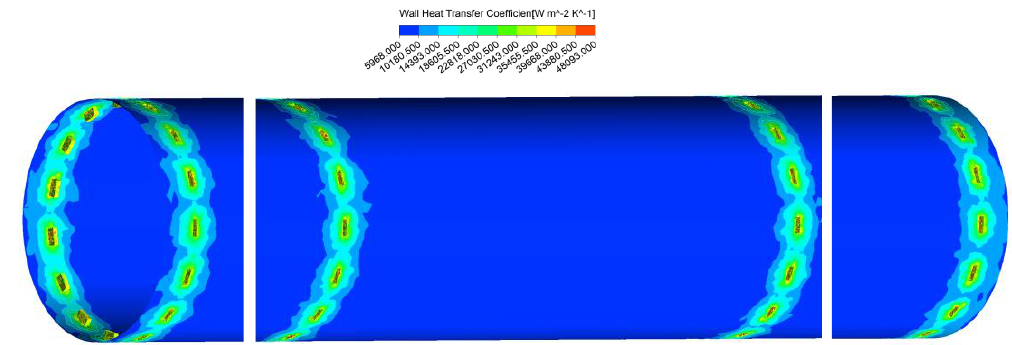
Figure 6. Local wall heat transfer coefficient contours on the wall of the tube.